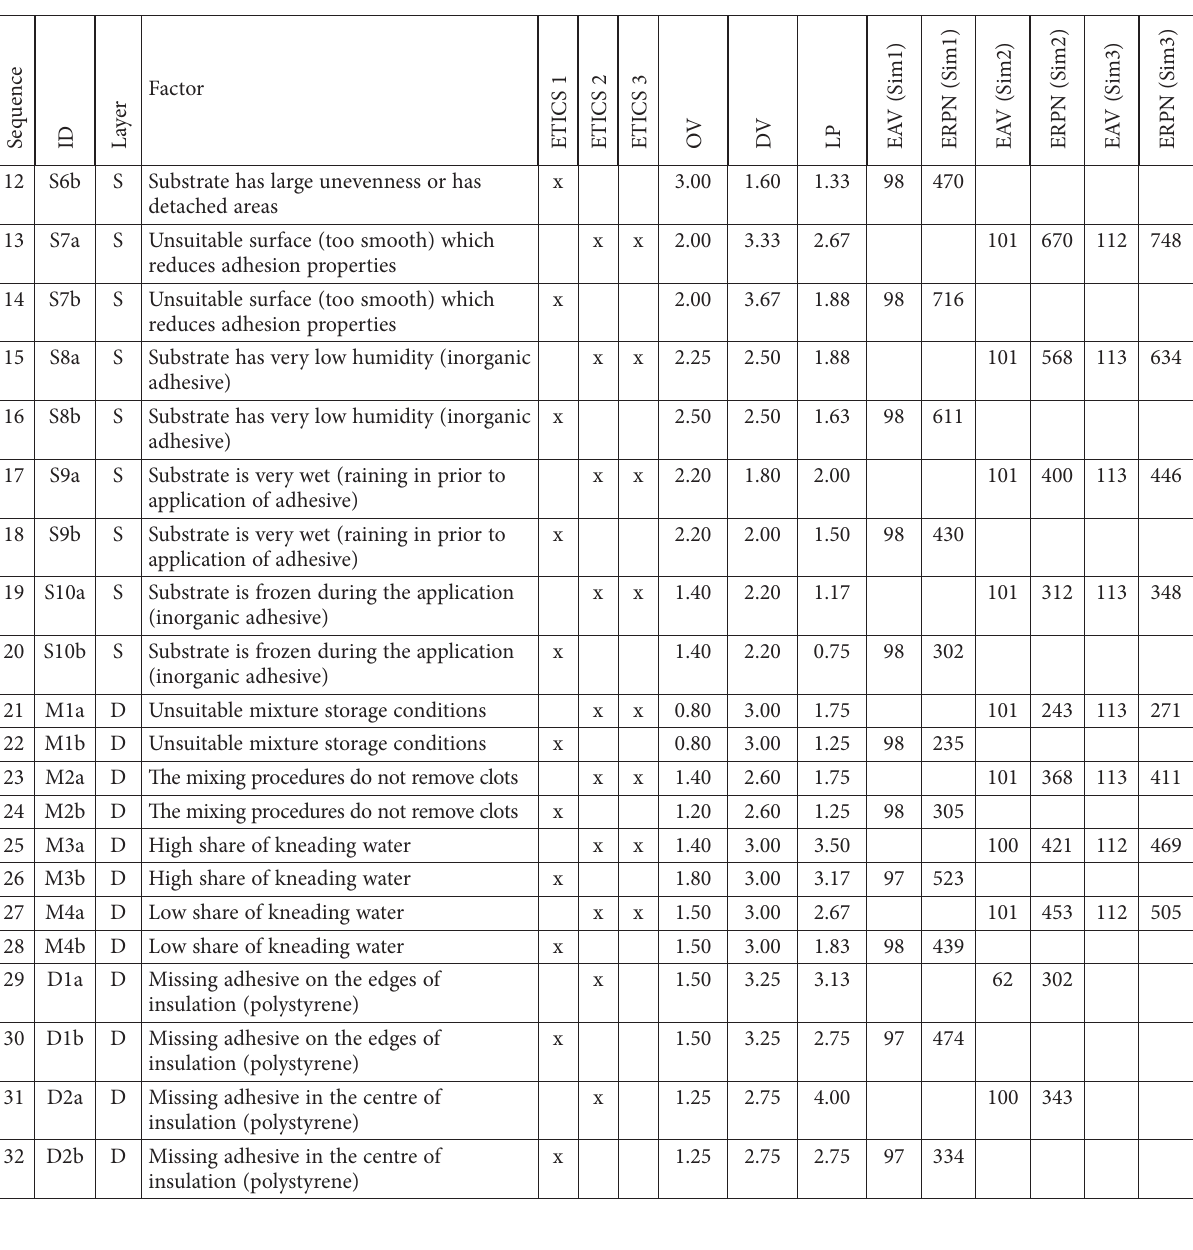
Table A2. Data for equation (2